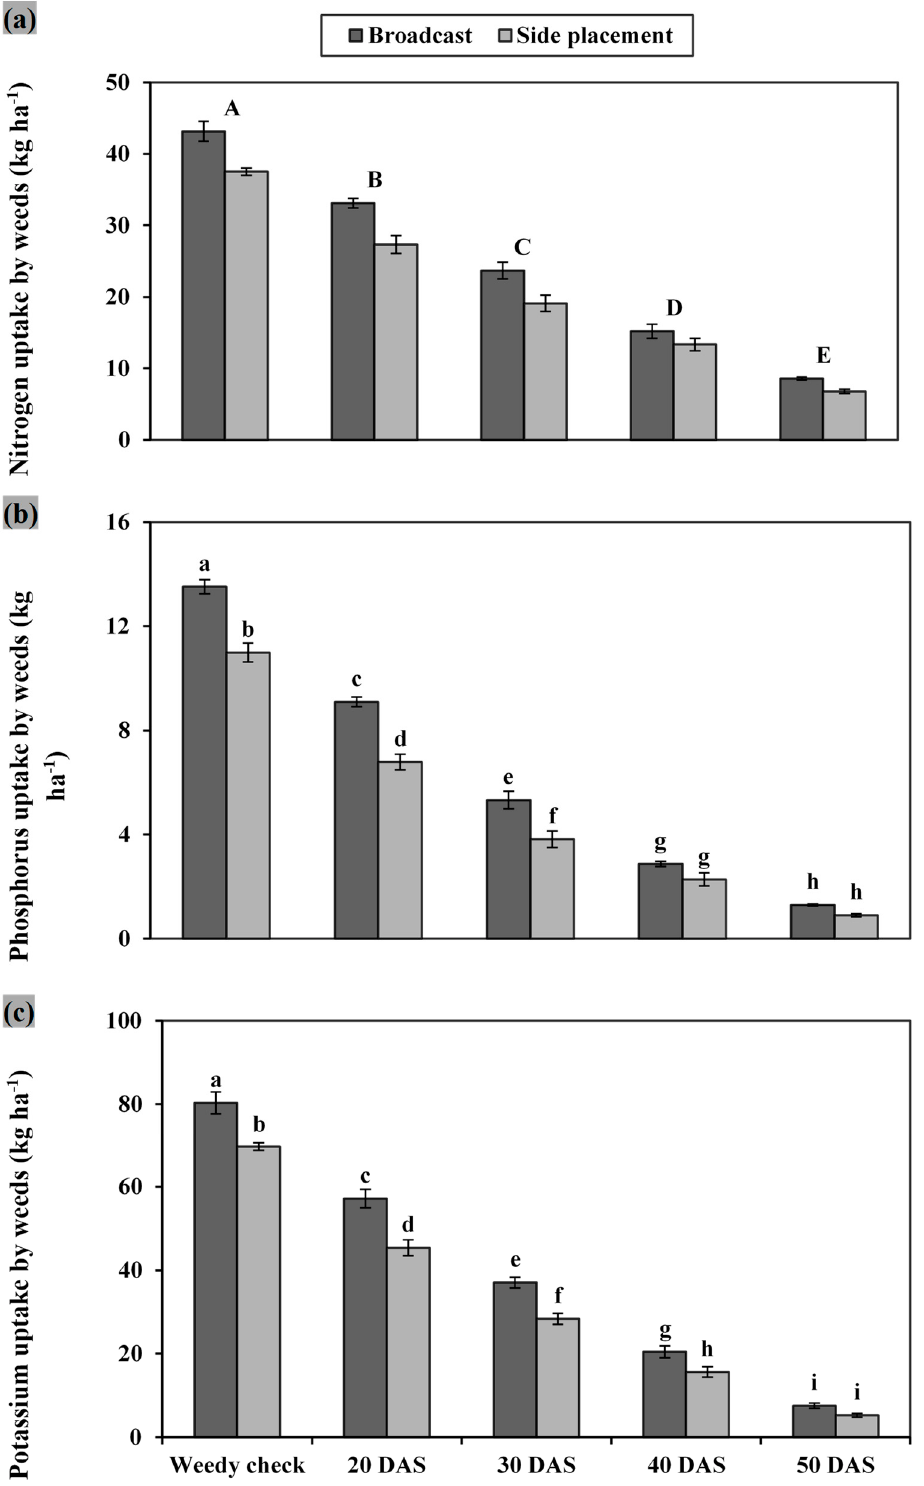
Figure 5. Effects of different weed-free periods on ( a ) nitrogen uptake, ( b ) phosphorous uptake and ( c ) potassium uptake by weeds in direct-seeded rice under different fertilizer application methods. Vertical bars above mean denote the standard error ( ± ) of six replicates small letters depict significance at 5% probability level. Units on x -axis remain same for a, b and c figures. Capital letters represent same letter for both fertilizers methods, (2 years mean data).